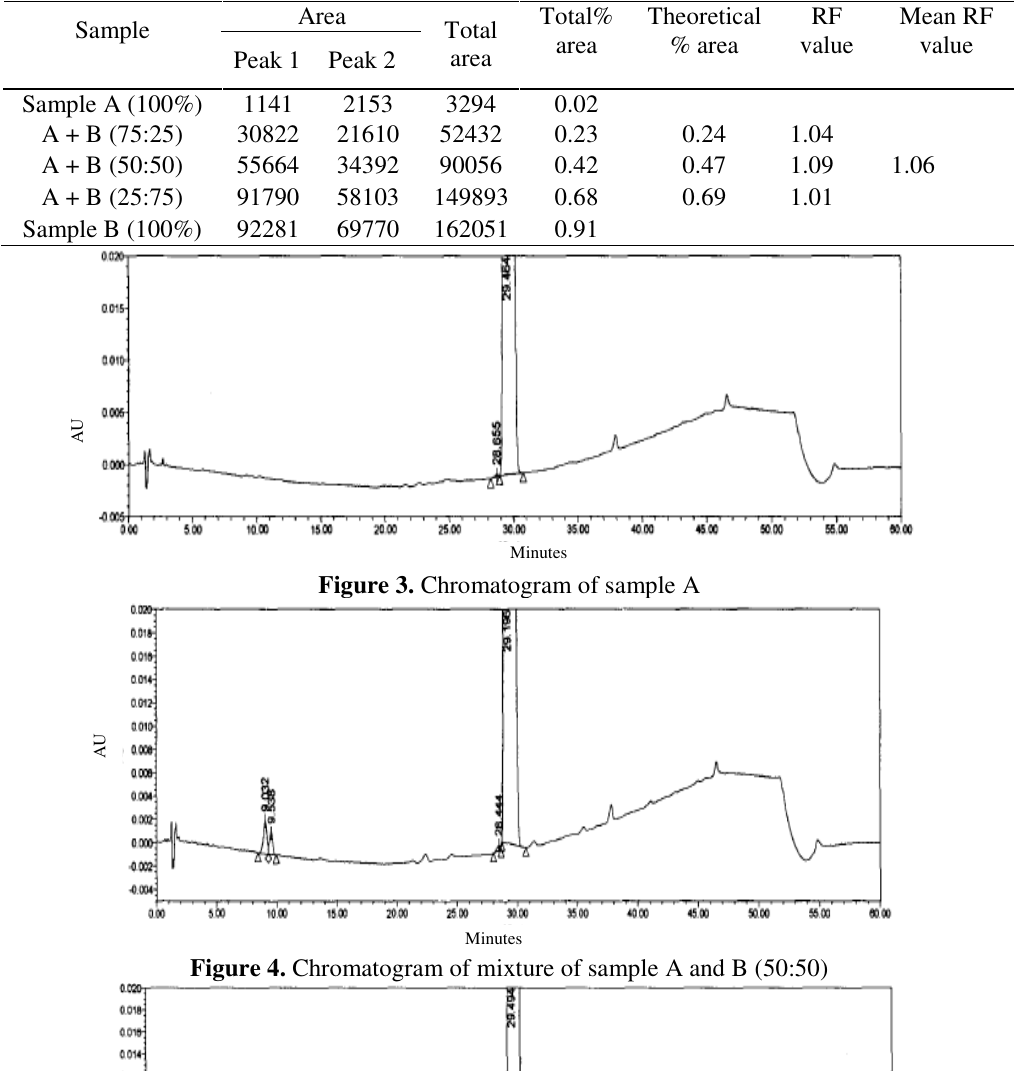
Table 1. Determination of RF value of unknown impurity (Approach-1)